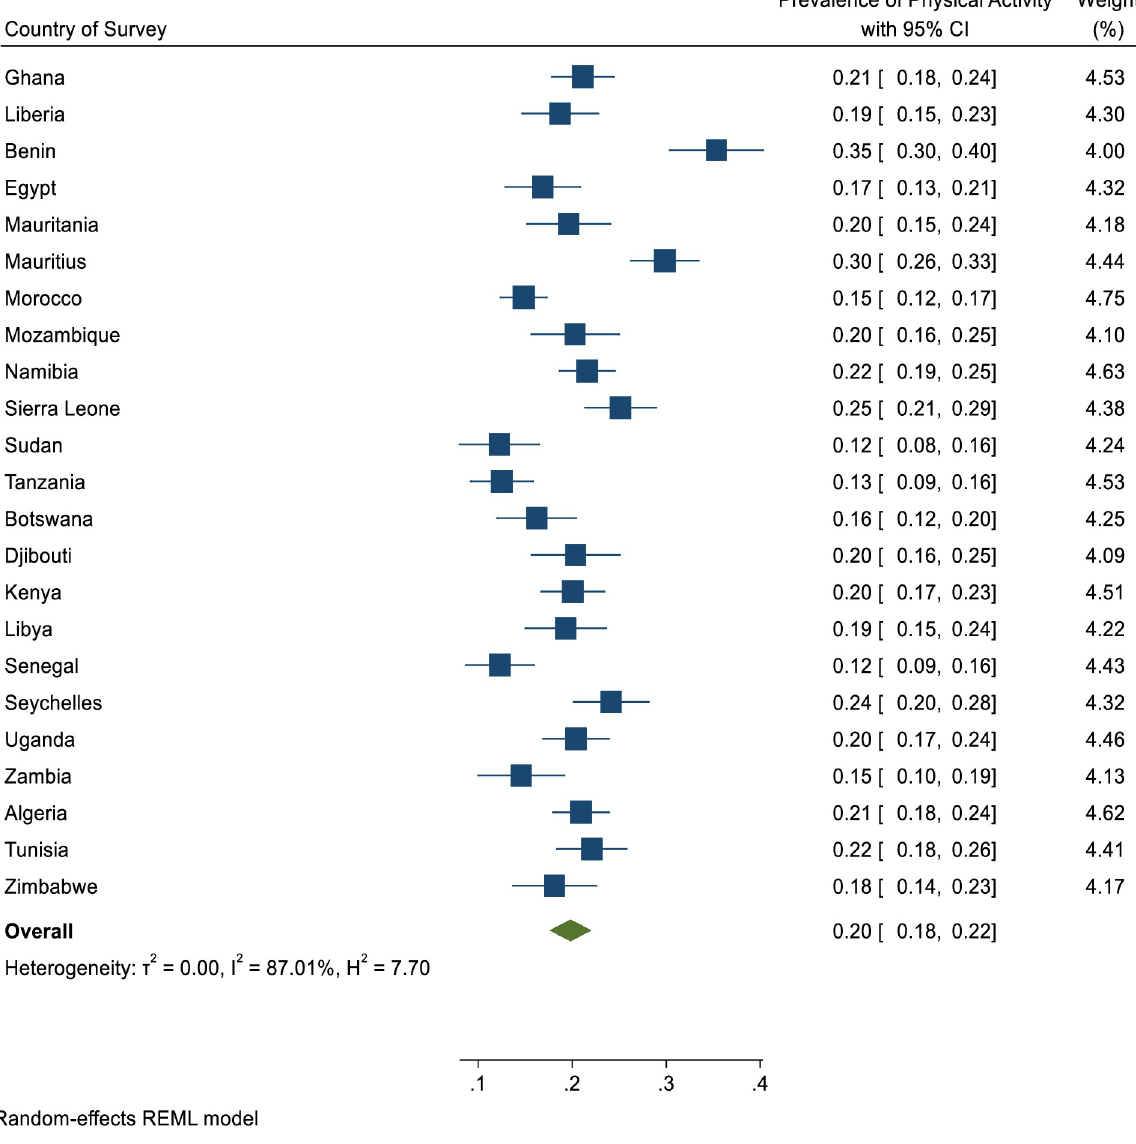
Fig 1. Pooled estimated prevalence of sufficient physical activity level across 23 African